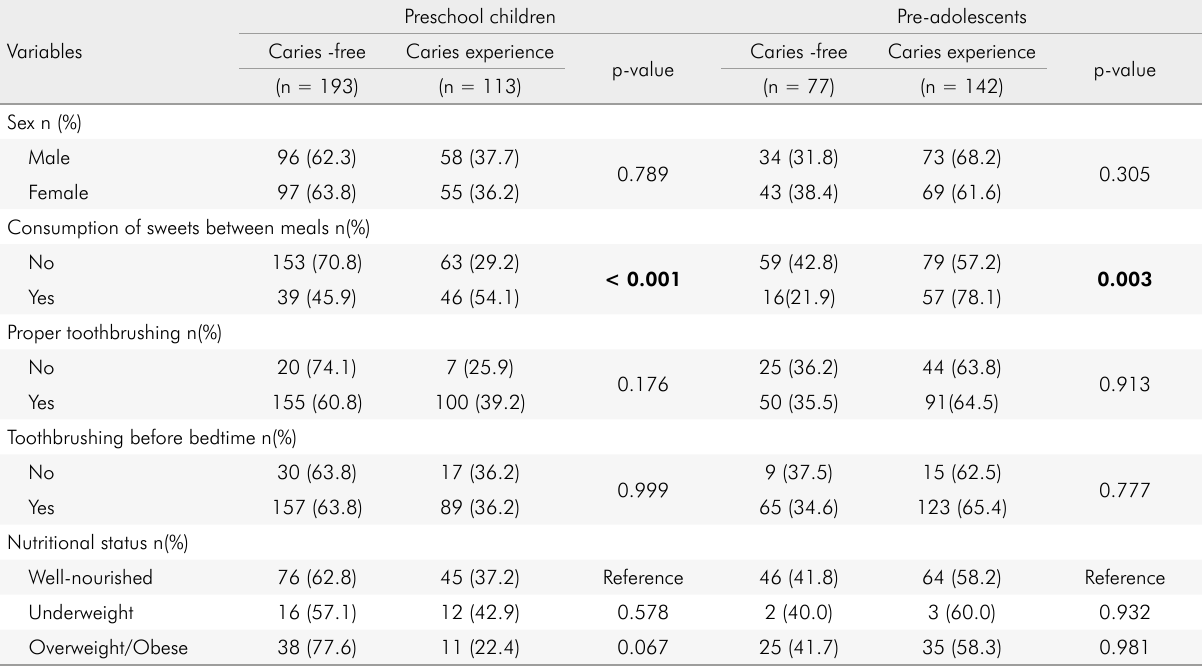
Table 1. Distribution of independent variables in caries groups among preschool children and pre-adolescents.